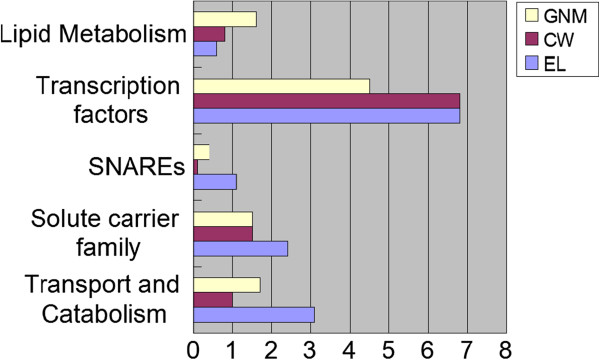
Accumulation of domestication and improvement genes in different pathways of KEGG (χ2 test, P < 0.05). CW: domestication genes; EL: improvement genes; GNM: genome wide genes.